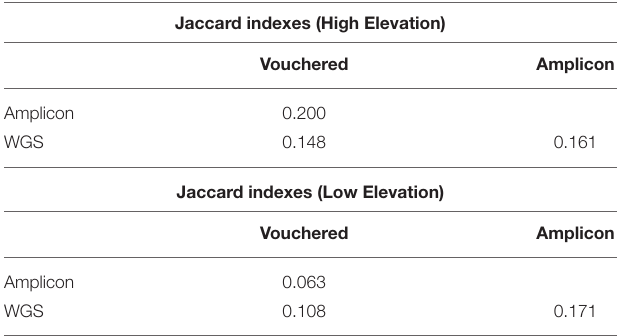
TABLE 2 | Comparison of the congruence between the species detected by either method and the vouchered species at each plot. Jaccard indexes (High